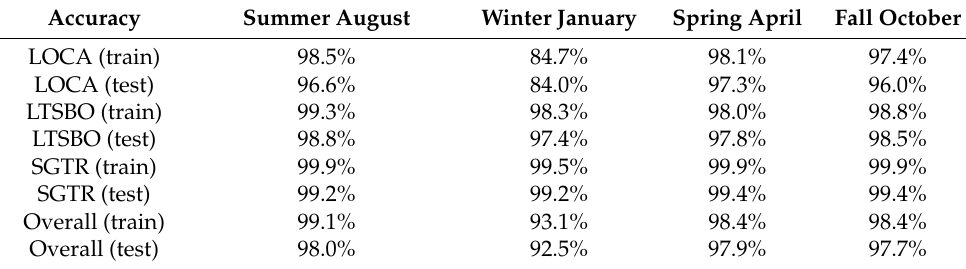
Table 3. The accuracy of the four models tested.